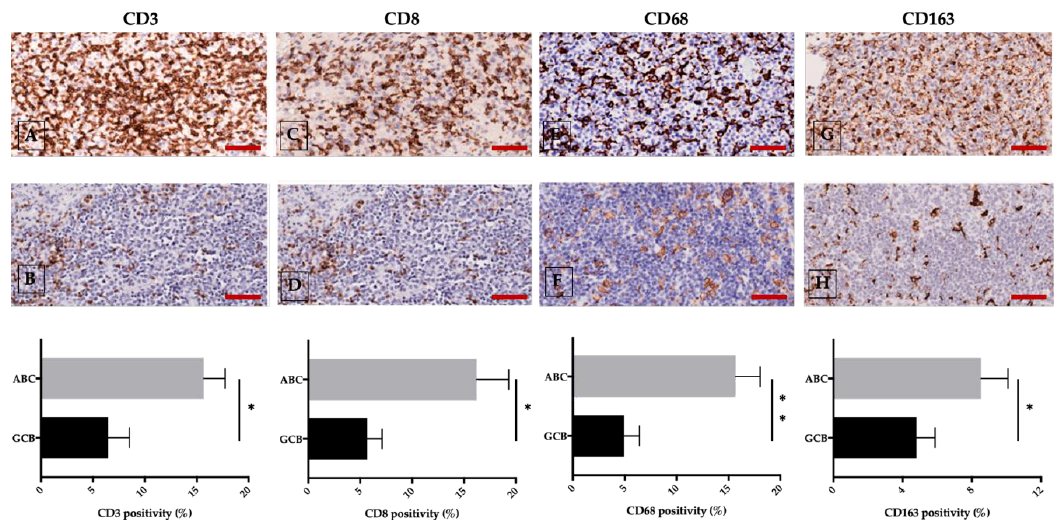
Figure 4. ABC (upper panel) and GCB (middle panel) DLBCL different expression of CD3 ( A , B ), CD8 ( C , D ) CD68 ( E , F ), and CD163 ( G , H ) assessed by immunohistochemical staining. The morphometric analysis is expressed as marker percentage positivity (lower panel). Scale bar: A – H 60 μm. Representative images from 60 untreated DLBCL patients are presented; * p < 0.05; ** p < 0.01, assessed by Mann–Whitney test [116].